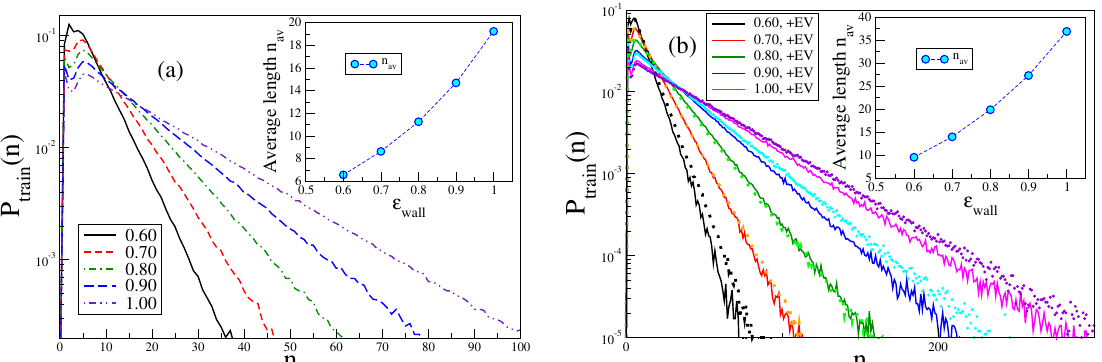
Figure 10. Probability distribution P train ( n ) to observe trains having a length of n monomers, for N = 750 and two choices of κ , κ = 5 ( a ); and κ = 8 ( b ). Five choices of (cid:101) wall are included, as indicated. In case ( b ), symbols indicate data with EV shut off while curves show data including EV. (cid:82) dnP train ( n ) n Inserts show the average train length, defined from n av =